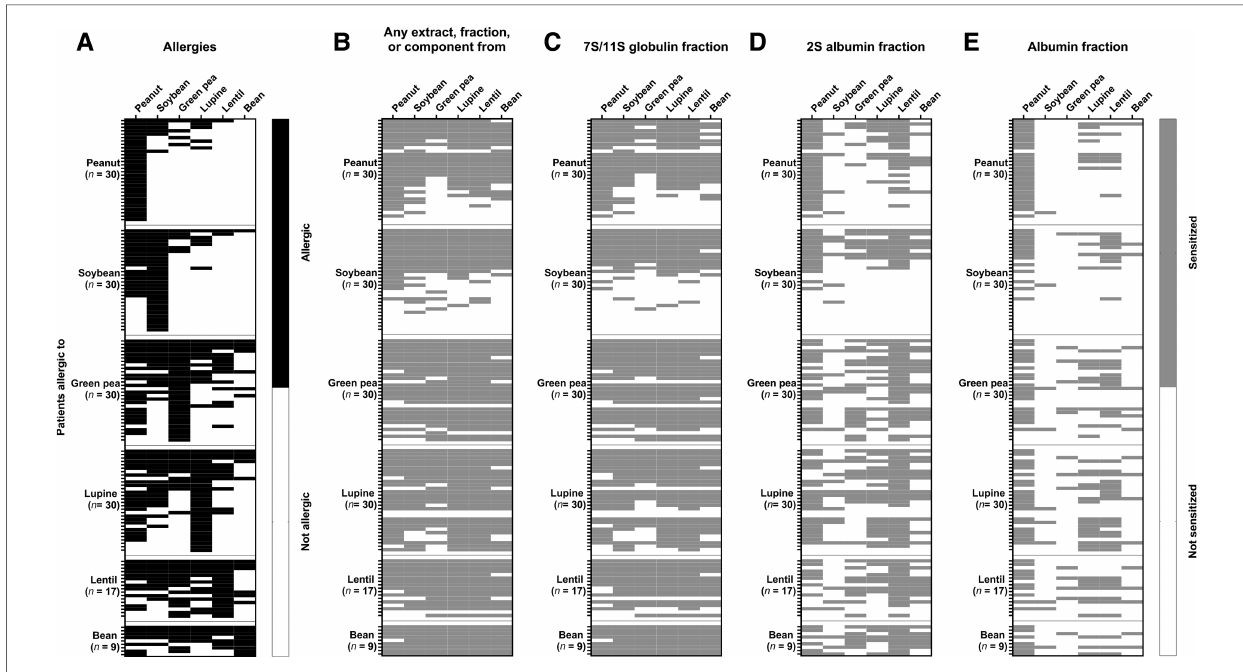
FIGURE 3 Heat maps showing the frequency of legume allergy and the frequency of sensitization. ( A ) A legume allergy (black cells) was established by either a positive food challenge or a convincing history of legume-allergic reactions combined with a positive IgE test in blood. ( B ) The frequency of sensitization (grey) for any extract, protein fraction, or protein, ( C ) the 7S/11S globulin fraction, ( D ) the 2S albumin fraction, ( E ) and the albumin fraction are also